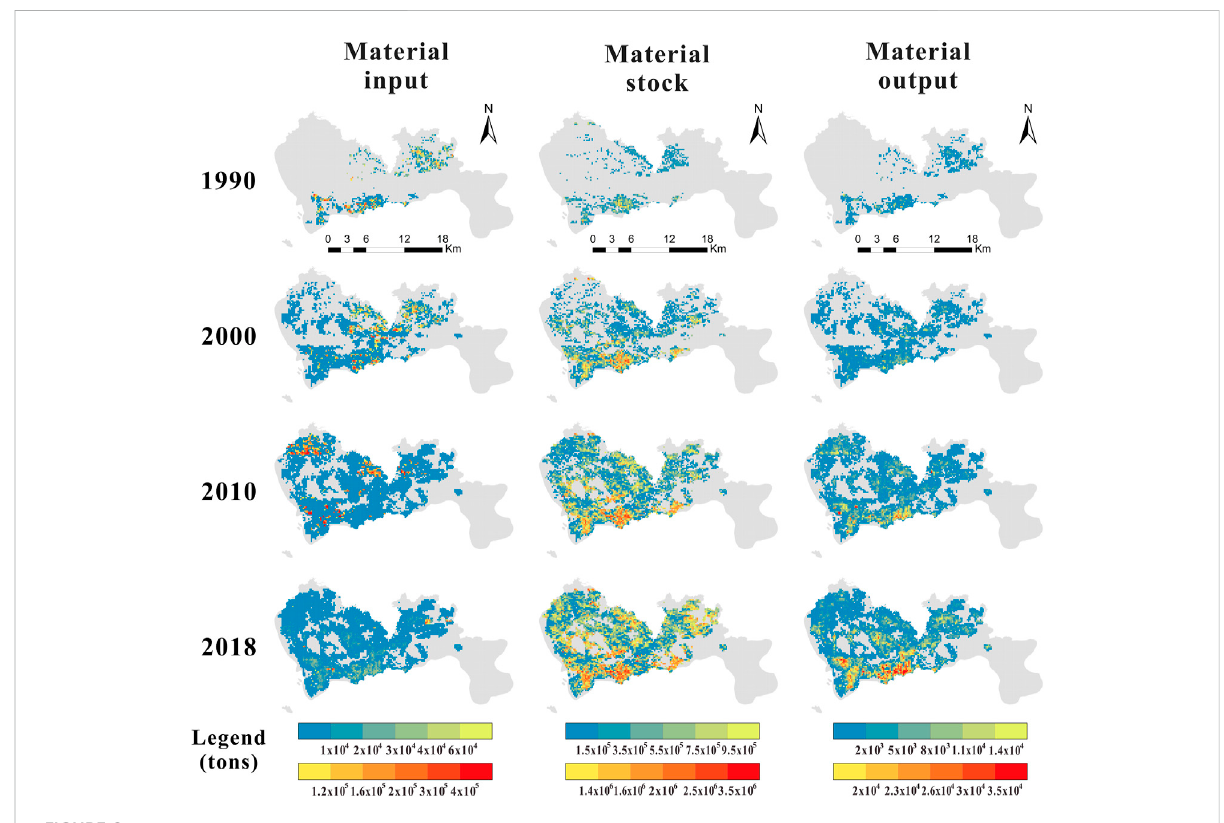
FIGURE 8 Spatial patterns of material metabolism in buildings of Shenzhen, China (1990 –